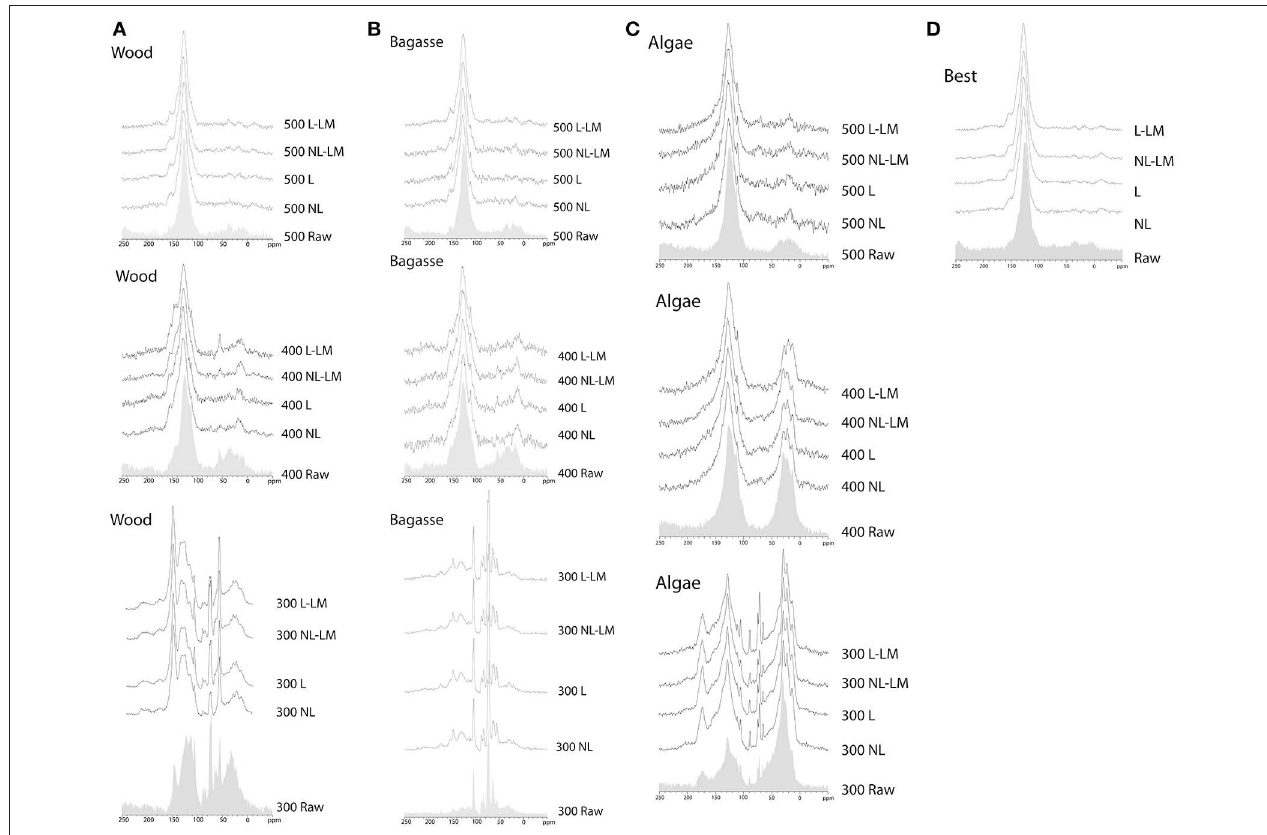
FIGURE 3 | 13 C-MAS-NMR spectra of samples before and after exposure to environmental conditions. (A) Nothofagus wood biochar, (B) S. officinarum biochar, (C) Algae biochar, (D) BEST biochar. Spectra are given for uncharred (raw) material and samples prepared at 300 ◦ C, 400 ◦ C and 500 ◦ C emplaced in the four different treatments described in the